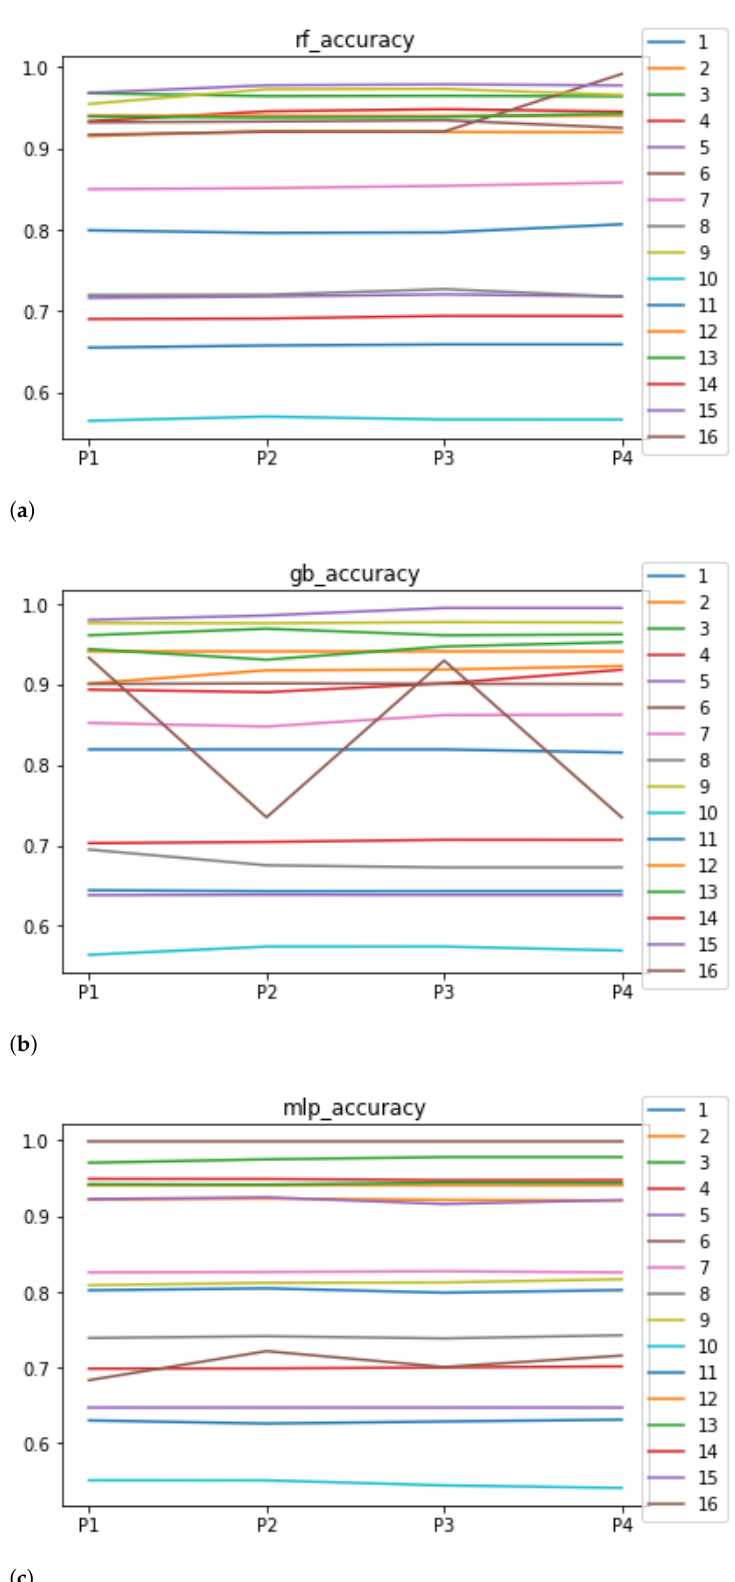
Figure 4. Behavior of RHOASo: accuracy. Each line represents a dataset. ( a ) Accuracy for RF. Axis X: the partition of the dataset. Axis Y: the obtained accuracy. ( b ) Accuracy for GB. Axis X: the partition of the dataset. Axis Y: the obtained accuracy. ( c ) Accuracy for MLP. Axis X: the partition of the dataset. Axis Y: the obtained